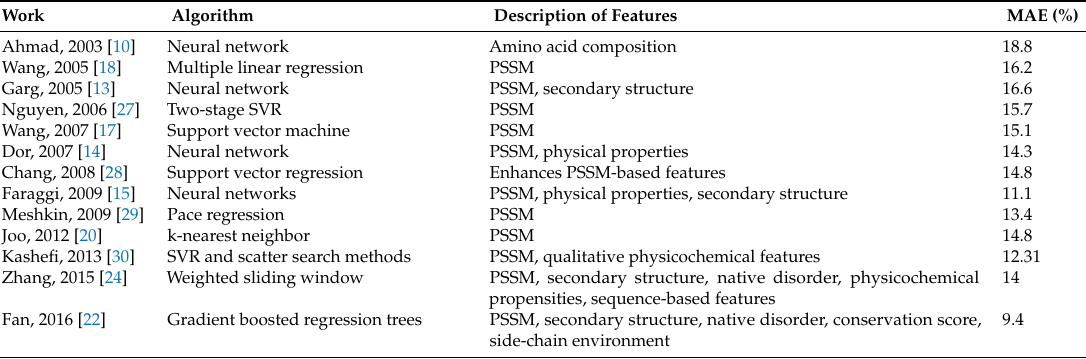
Table 1. The recent developments, in chronological order, for predicting the values of